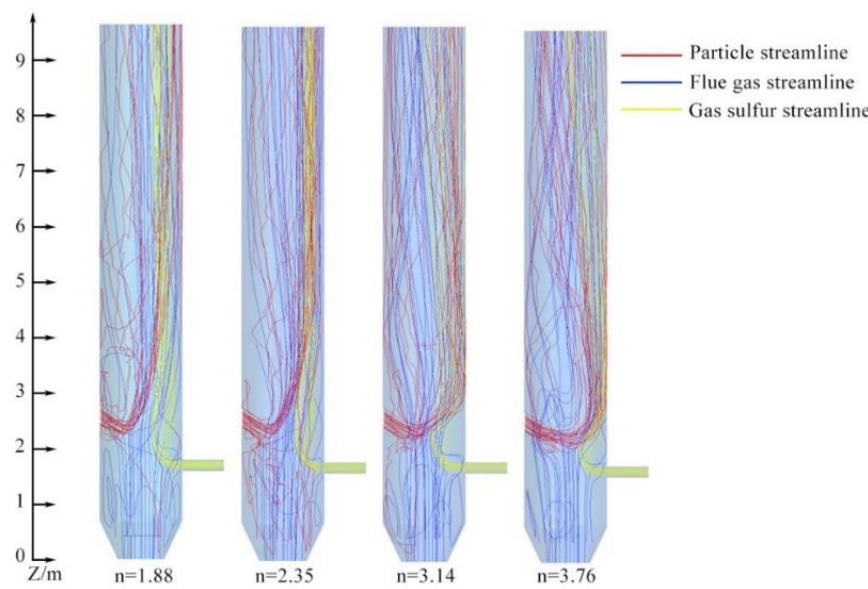
Figure 9. Flow diagram in reduction furnace under different n (CaSO 4 )/ n (S 2 ).